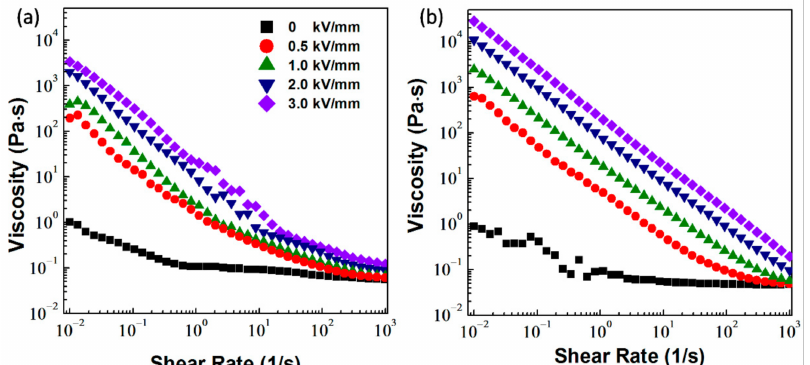
Figure 3. Shear viscosity curves of the electrorheological (ER) fluids of cellulose ( a ) and cellu- lose/Laponite composite ( b ) as a function of shear rate measured at different electric field